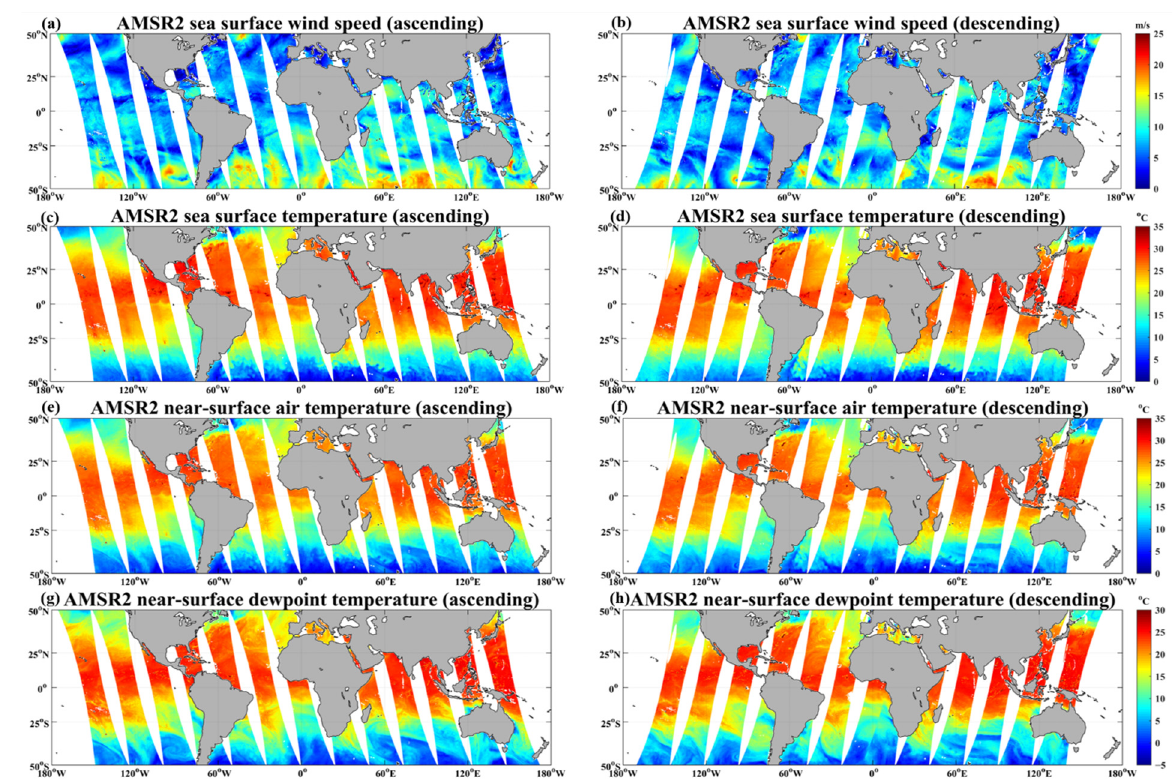
Figure 8. The multi − parameter BPNN model retrieved the global daily instantaneous fields for sea surface wind speed (WS), sea surface temperature (T s ), near − surface air temperature (T a ), and dewpoint temperature (T d ) from AMSR2 ascending and descending brightness temperature observations for 13 July 2018. Panels ( a , c , e , g ) represent ascending overpasses, and ( b , d , f , h ) stand for descending overpasses.